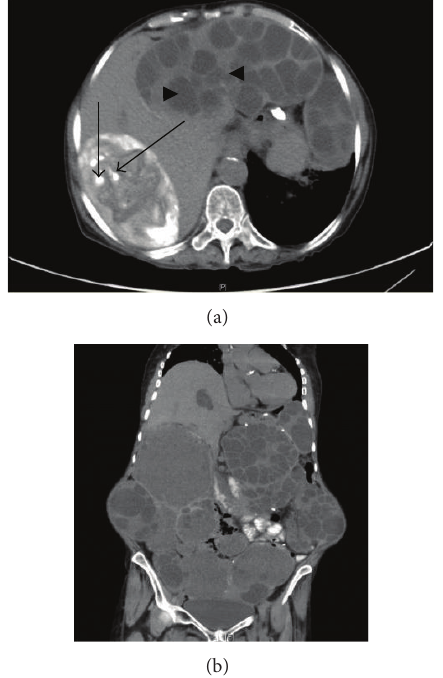
Figure 2: (a) CT scan abdomen showing multiple cystic lesions of variable appearance and size, with partial calcification “long arrows” and intrahepatic daughter cyst “arrow head.” (b) Multiple cystic lesions of variable appearance and size with septa and wall